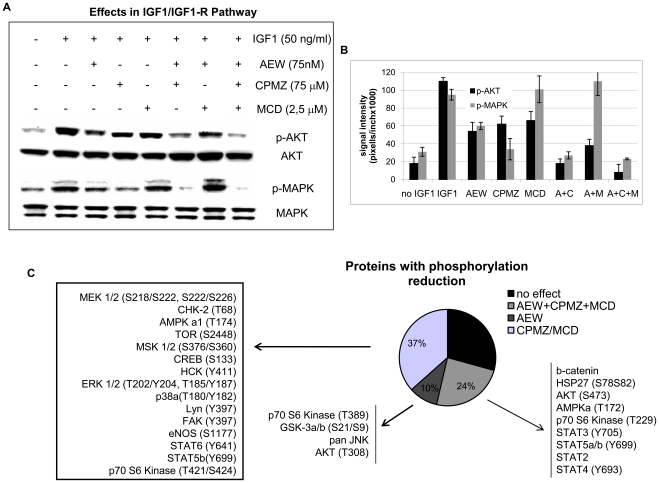
Effects of IGF1R tyrosine kinase inhibition combined with CAV1 and/or clathrin inhibition on the ES cell phospho-proteome.
A) AKT and MAPK42/44 protein levels and B) densitometric evaluation. The reduction in the phosphorylation of AKT and MAPK42/44 was over 60%. C) Graphic representation of the most relevant changes in protein phosphorylation. Some of them underwent the strongest reduction in phosphorylation simply with CPMZ/MCD treatment (p38, ERK1/2, MEK1/2, or TOR). However, others needed the triple combination in order for the lowest levels of activation to be obtained (such as AKT, HSP27, or AMPKa1). A: AEW, C: CPMZ and M: MCD treatments; + control: IGF1 stimulation without drug treatment; - control: basal conditions, without IGF1 stimulation. Data presented is representative of 3–5 independent experiments for the WB studies and 3 independent experiments for the phospho kinase array.